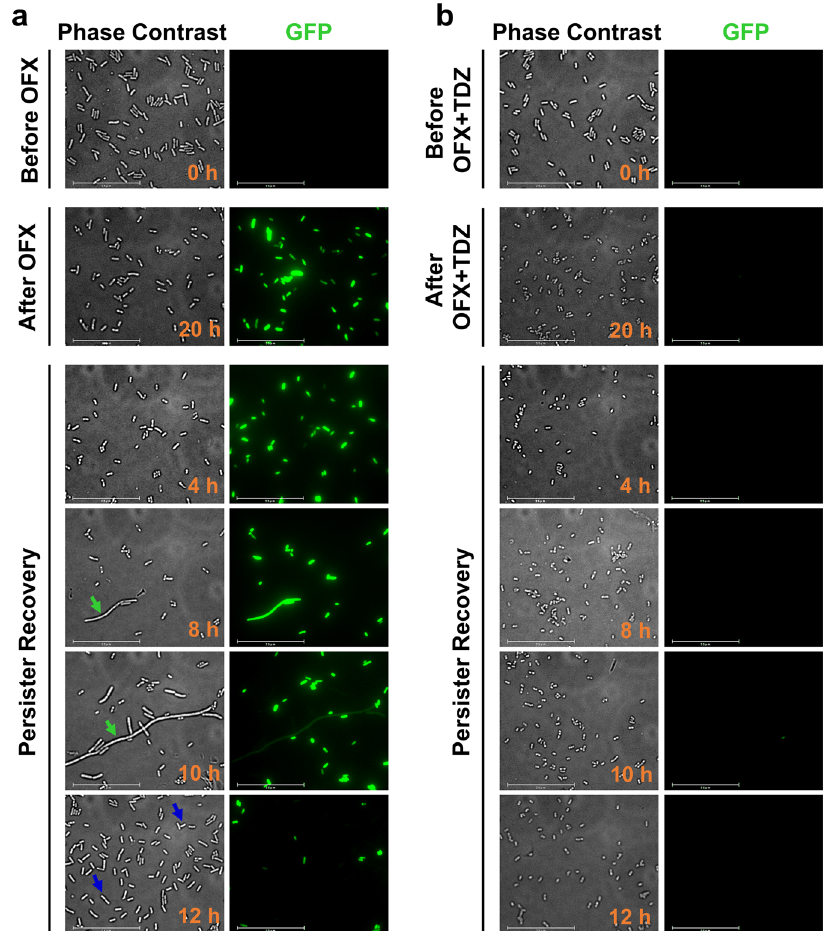
Fig. 4 Phenothiazine drugs perturb OFX-induced RecA expression during recovery. Early stationary phase E. coli MG1655 cells with P recA -gfp (grown in LB) were treated with ( a ) OFX or ( b ) OFX + TDZ for 20 h. After treatment, cells were washed and transferred to liquid LB medium for persister recovery. At designated time points during persister recovery, 10 µ l cells samples were spotted on 1% agarose pads for phase contrast and fl uorescent microscopy. A representative image is shown; all independent biological replicates have similar results. Green arrow: elongated cells with high GFP, blue arrow: dividing exponential phase cells with low GFP. n = 3. Scale bar: 25 µ